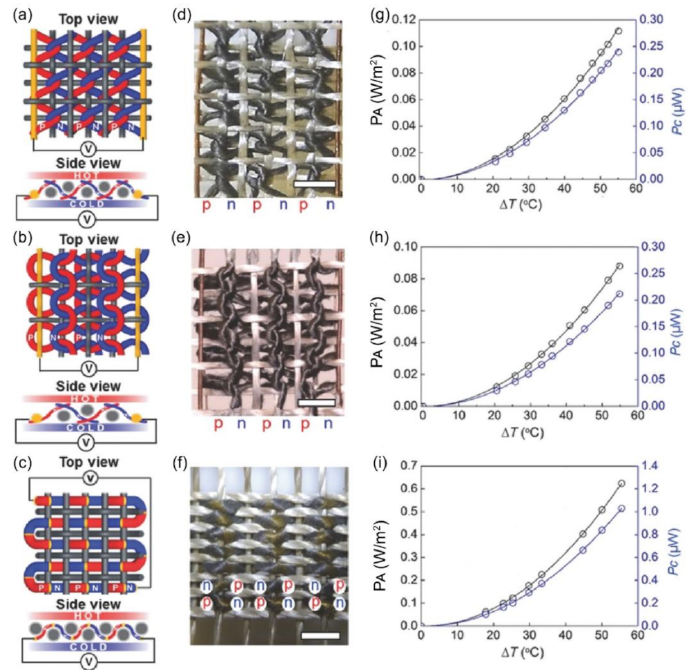
Figure 3. Woven-yarn TE fabrics [75]. ( a – f ) Illustration ( a – c ) and photographs ( d – f ) of zigzag, garter, and plain-weave TE textiles, respectively. Scale bar = 2 mm. ( g – i ) The output power per textile area and per TE couple as a function of applied thermal gradient ( ∆ T ) for zigzag, garter, and plain-weave TE textiles, respectively. Reproduced with permissions [75]. Copyright 2016, 2016 WILEY-VCH Verlag GmbH & Co. KGaA,